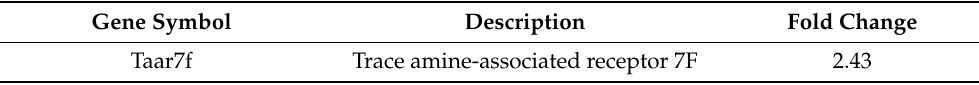
Figure 3. ( A ) The number of TRPA1-positive trigeminal ganglion neurons on day 24 in the SiH and CfH groups. ( B ) The immunostaining of TRPA1-positive trigeminal ganglion neurons (arrows) on day 24 in the SiH and CfH groups. Scale bars 50 µm. *: p < 0.05 and **: p < 0.01 vs. the SiH group (Student’s t -test). Table 1. DNA microarray analysis in blood